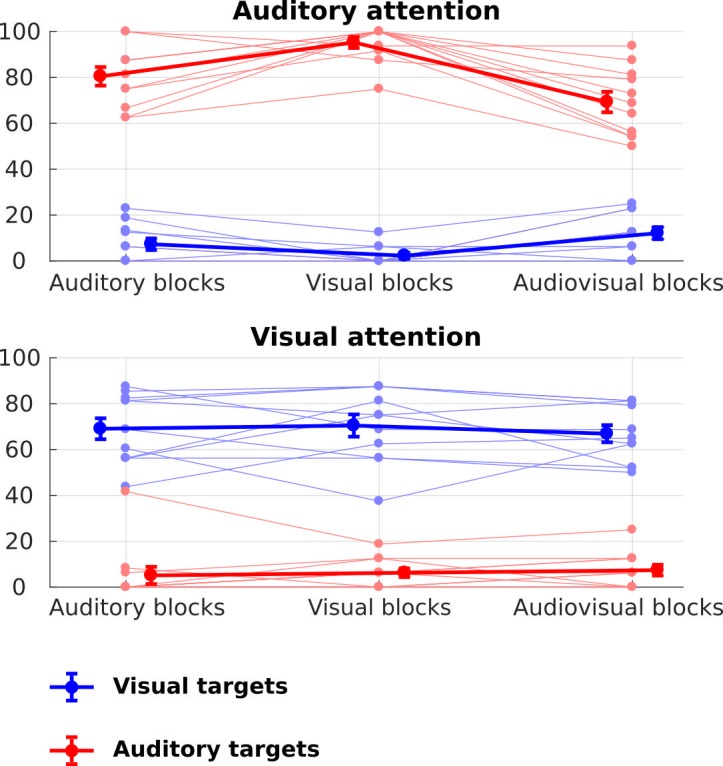
Behavioural results.Percentage of responses to auditory (red) and visual (blue) targets in auditory, visual and audiovisual blocks (along the x-axis) and under auditory (top panel) and visual (bottom panel) attention. Thick lines represent group means + /- SEM and each thin line represents a participant. Responses to visual targets under auditory attention and responses to auditory targets under visual attention are false alarms (and vice versa for visual attention).